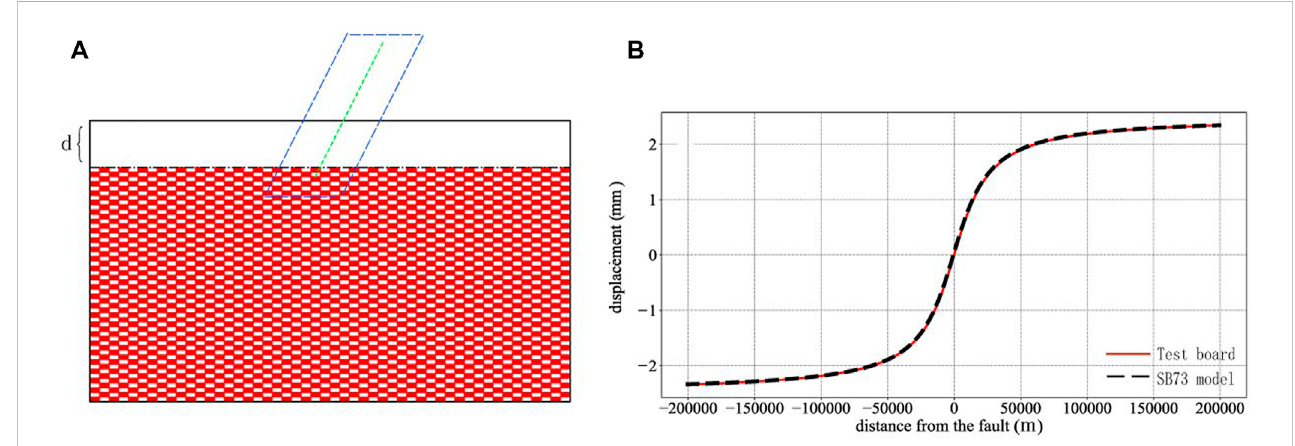
FIGURE 10 Results of test board fault. When the number of patches is 100 × 100 (cid:1) 10000, the deformation curve is very close to the arctangent function. (A) Test board fault; green dash line means measurement points, s (cid:1) 10mm/a and d (cid:1) 20km; (B) curve made by the test board fault and the SB73 model with s (cid:1) 5mm/a and d (cid:1)